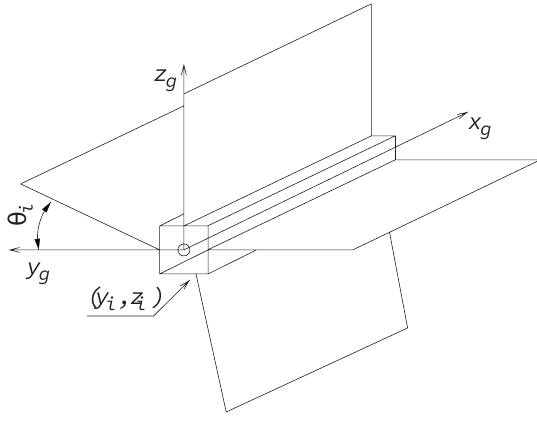
Fig. 1. The junction under analysis with the global reference system; position and orientation of a panel.